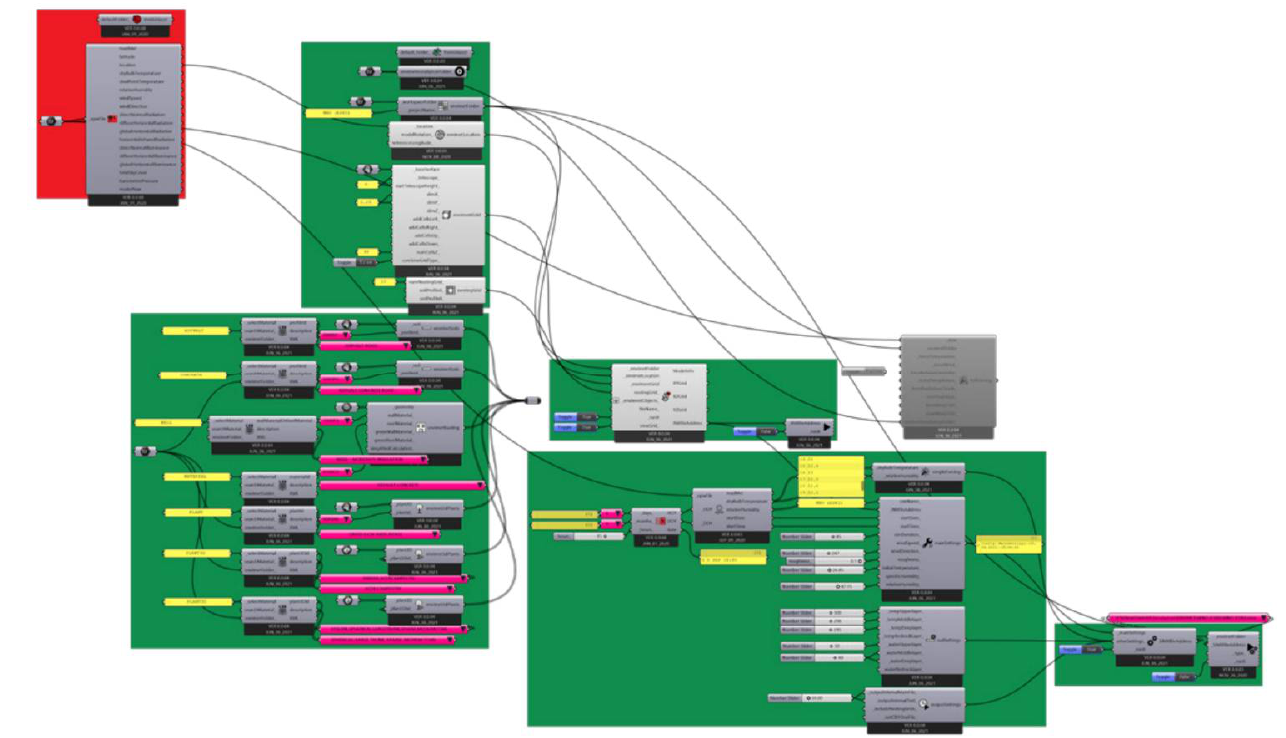
Figure 8. The simulation algorithm for outdoor environmental analysis.